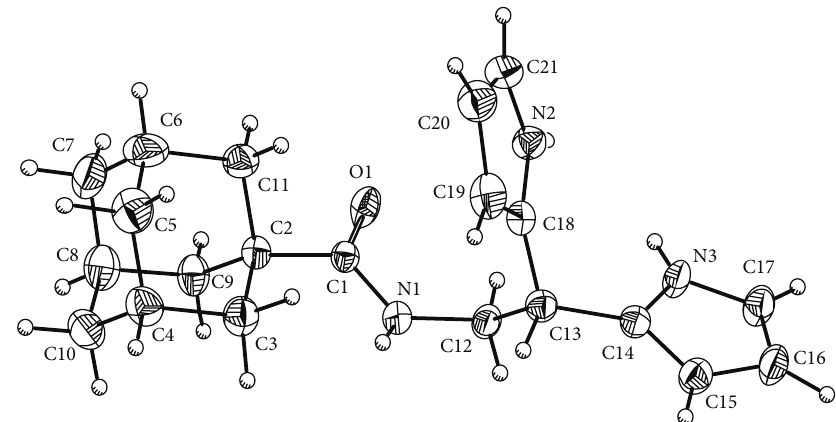
Figure 2: X-ray crystal structure of 1 (ORTEP, the displacement ellipsoids are scaled to the 50% probability level).